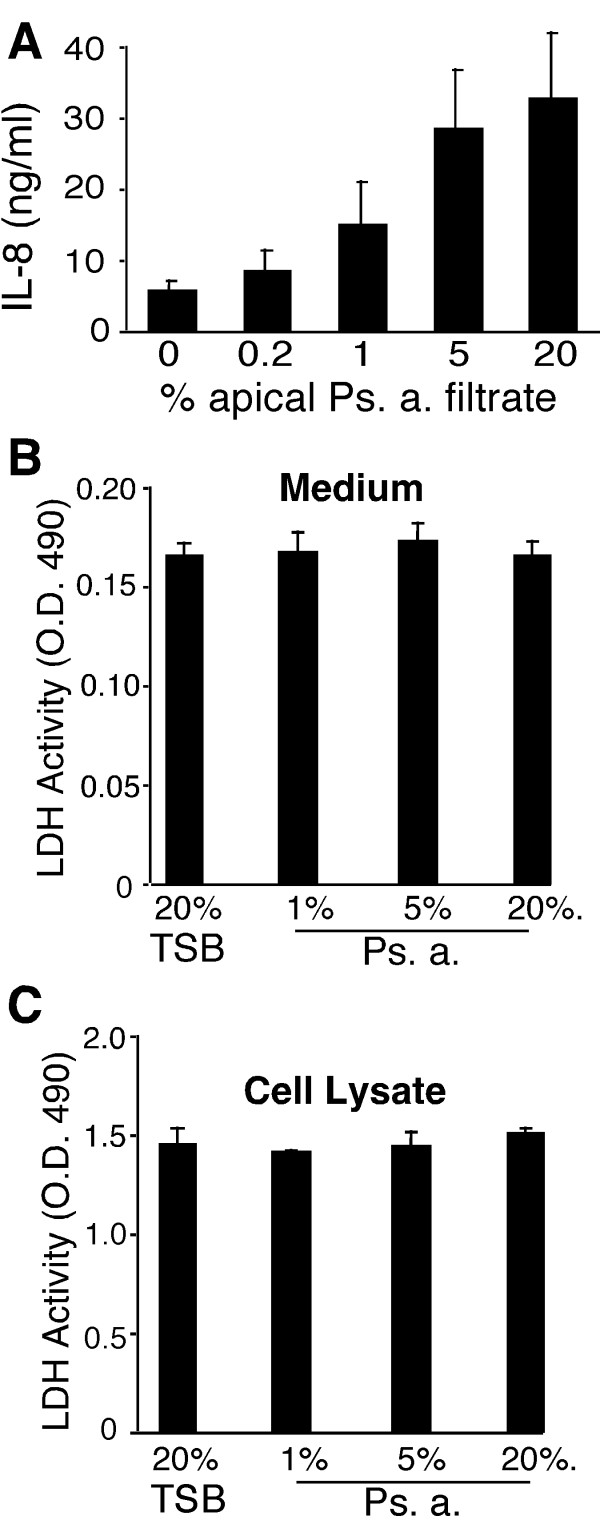
Treatment of well-differentiated hTBE cells with Ps. a. culture filtrates induced IL-8 secretion and was non-toxic. A) The apical surface of well-differentiated hTBE cell culures was challenged with the indicated concentration of Ps. a. filtrate or 20% TSB as a control (0% Ps. a. group) in the presence of 10% human serum, and IL-8 was measured in the 24-hour conditioned basolateral medium. The results are the mean + SEM from 3 independent experiments with cell cultures from 3 different donors. B and C) Ps. a. filtrate was essentially non-toxic as illustrated by lack of LDH secretion into the medium and retention of cellular LDH. The results are from three replicate wells (mean + SD).